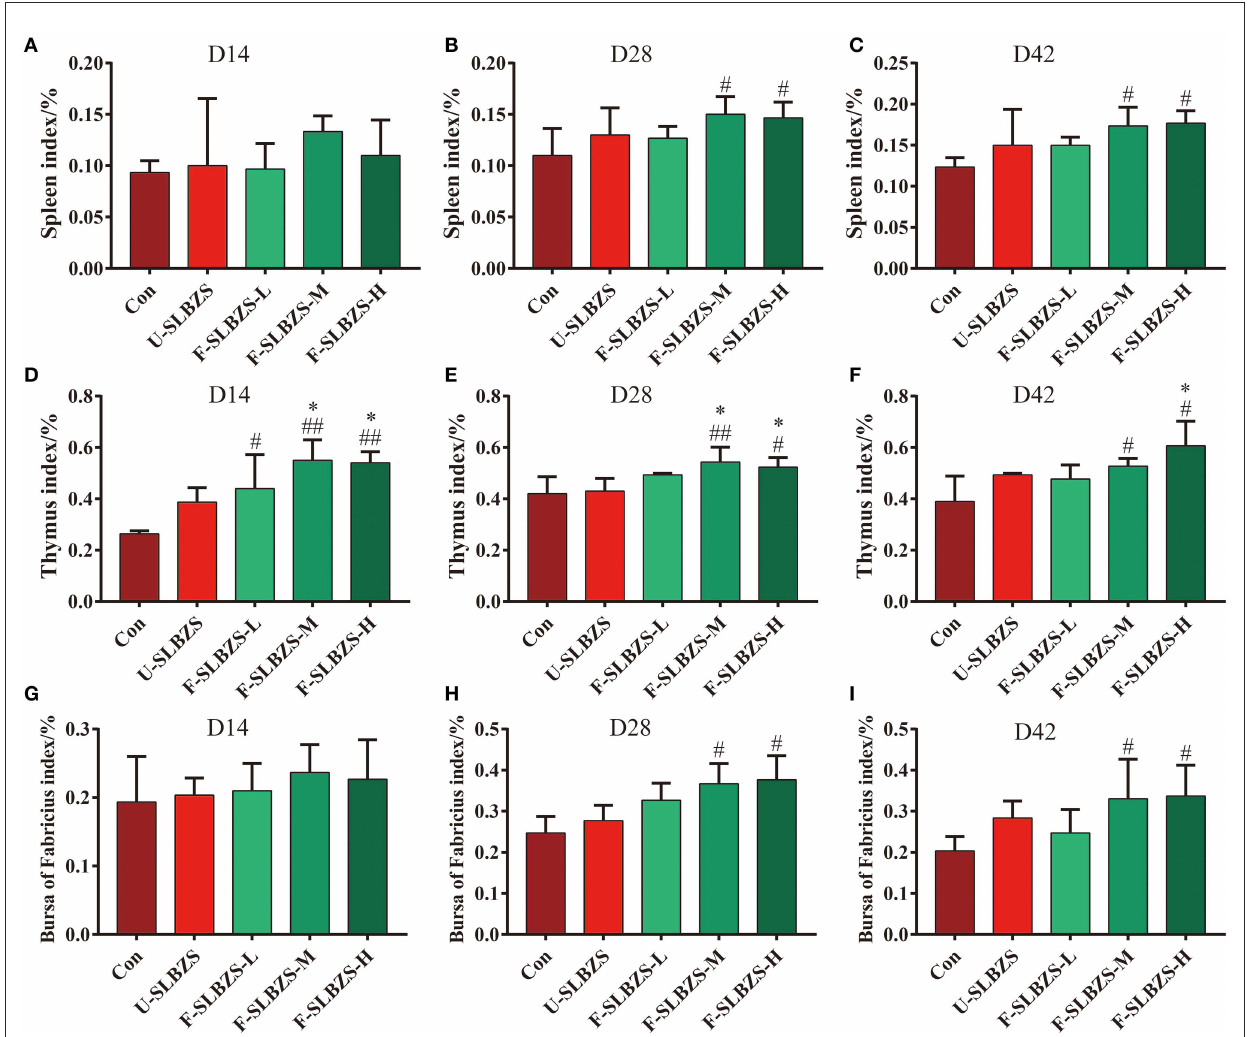
FIGURE3 Effects of fermented SLBZS on lymphoid organs weight of broilers. (A) Spleen index of broilers on day 14. (B) Spleen index of broilers on day 28. (C) Spleen index of broilers on day 42. (D) Thymus index of broilers on day 14. (E) Thymus index of broilers on day 28. (F) Thymus index of broilers on day 42. (G) Bursa of Fabricius index of broilers in on day 14. (H) Bursa of Fabricius index of broilers on day 28. (I) Bursa of Fabricius index of broilers on day 42. Bars represent mean values ± SD ( n = 3). # and ## indicate p < 0.05 and p < 0.01 compared with the Con group, * indicate p < 0.05 compared with the U-SLBZS